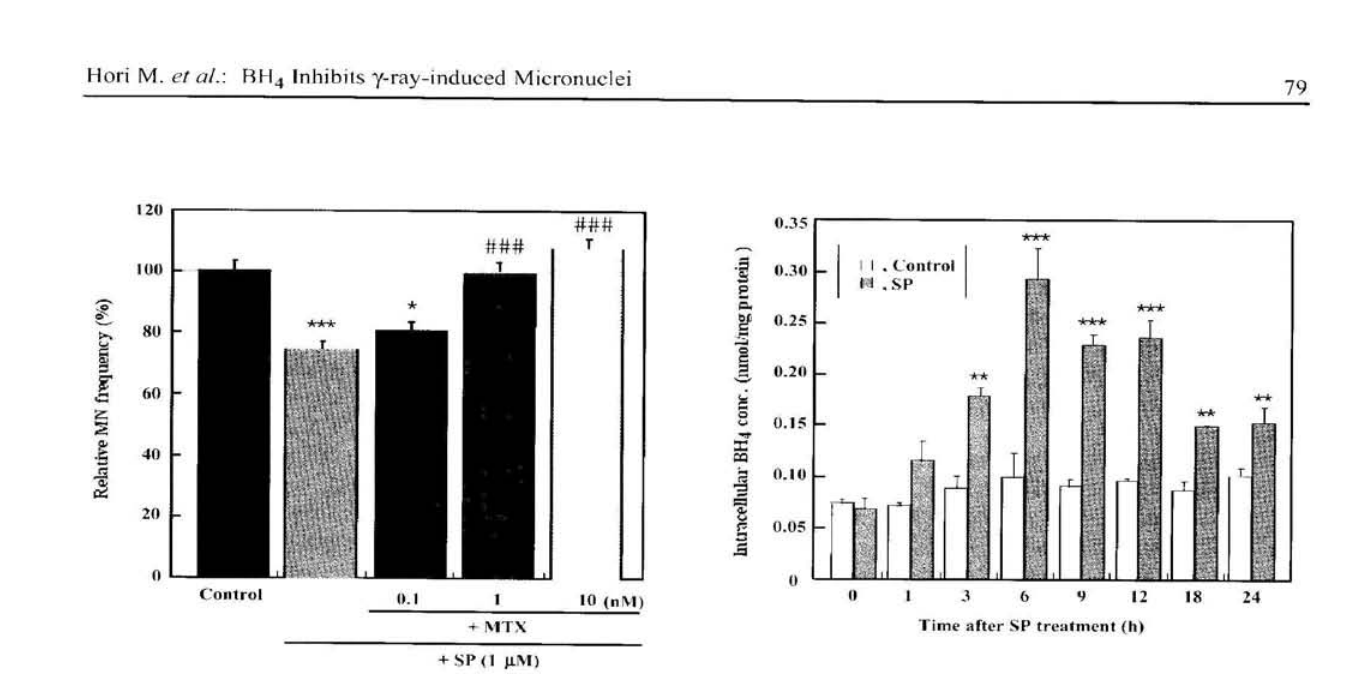
Figure 7. Changes of intracellular 5,6,7,8-tetrahydro- biopterin (BH4) concentrations after treatment with 1 mM sepiapterin (SP) in RAW264.7 cells. Intracellular BH4 concentrations in RAW264.7 cells were assayed at 0 to 24 h after 1 mM SP treatment. Each point indi- cates the mean ± SD of three independent assays. ** control group at p<0.01 and p<0.005,